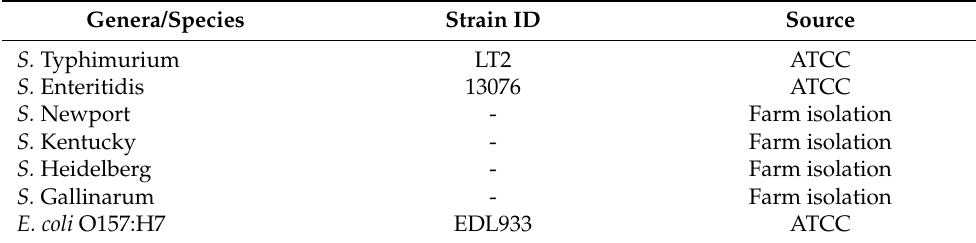
Table 1. Bacterial genera and species tested for phage in this